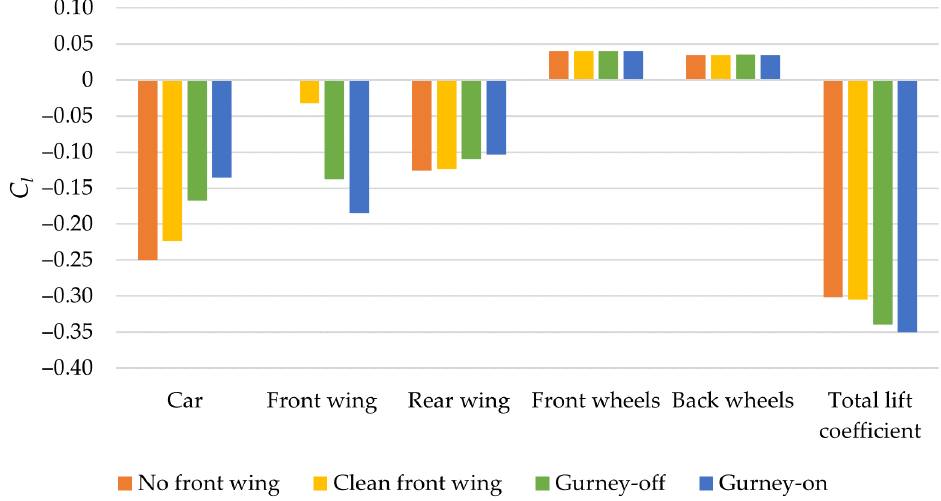
Figure 14. Lift coefficient distribution for cases without the front wing and with a front wing. It can be observed that the front wing without and with the Gurney flap generates negative lift and aerodynamic downforce. At the same time, there is a decrease in downforce generated by the body. The wing with the Gurney flap generates significant downforce when it has the Gurney flap in both the inactive and active positions. The lift generated by the rear wing increases slightly, which is caused by the wheels remaining constant. The aerodynamic downforce of a car with the front wing and Gurney flap active is 15% higher than for a car without a front wing.